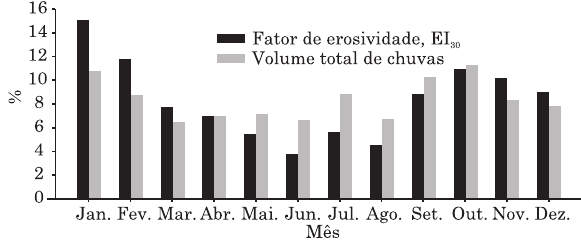
Figura 1. Valores médios mensais percentuais do fator de erosividade, EI 30 e do volume total das chuvas, obtidos entre 1989 e 2012, em Lages, SC (1) DP: desvio-padrão. (2) CV: coeficiente de